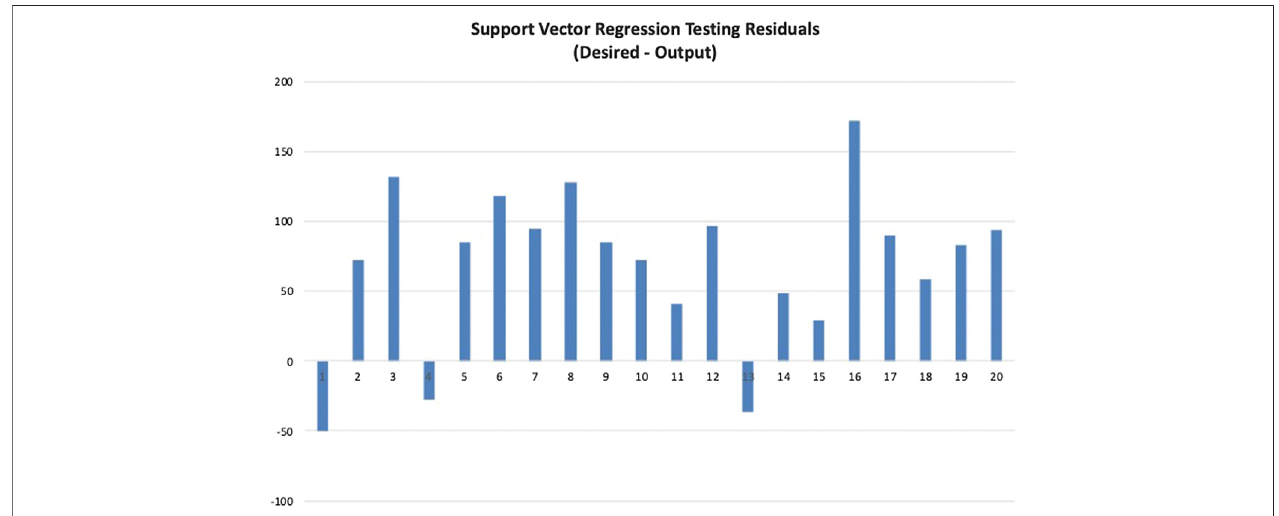
FIGURE 15 | Support vector regression model residual histogram.